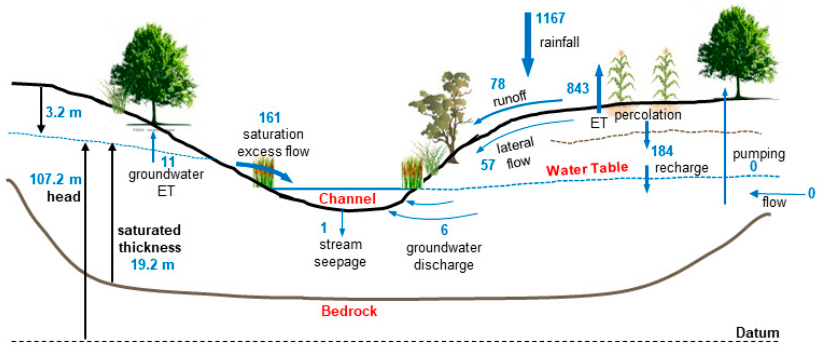
Figure 7. Average annual water balance for 1980–2013 for the LRW SWAT + simulation, with fluxes shown in mm / yr. Fluxes groundwater ET, saturation excess flow, stream seepage, groundwater discharge, boundary flow, and recharge and state variables groundwater head (m) and saturated thickness (m) are simulated using the new gwflow module of SWAT + .